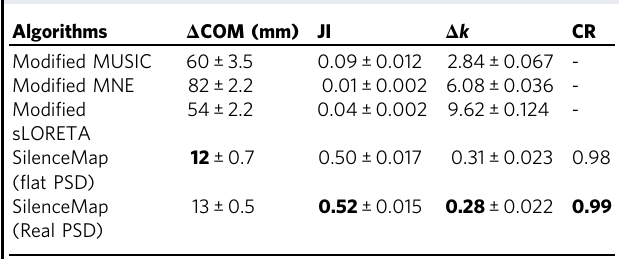
Table 1 Simulation experiment results (SNR avg = 9 dB, k =